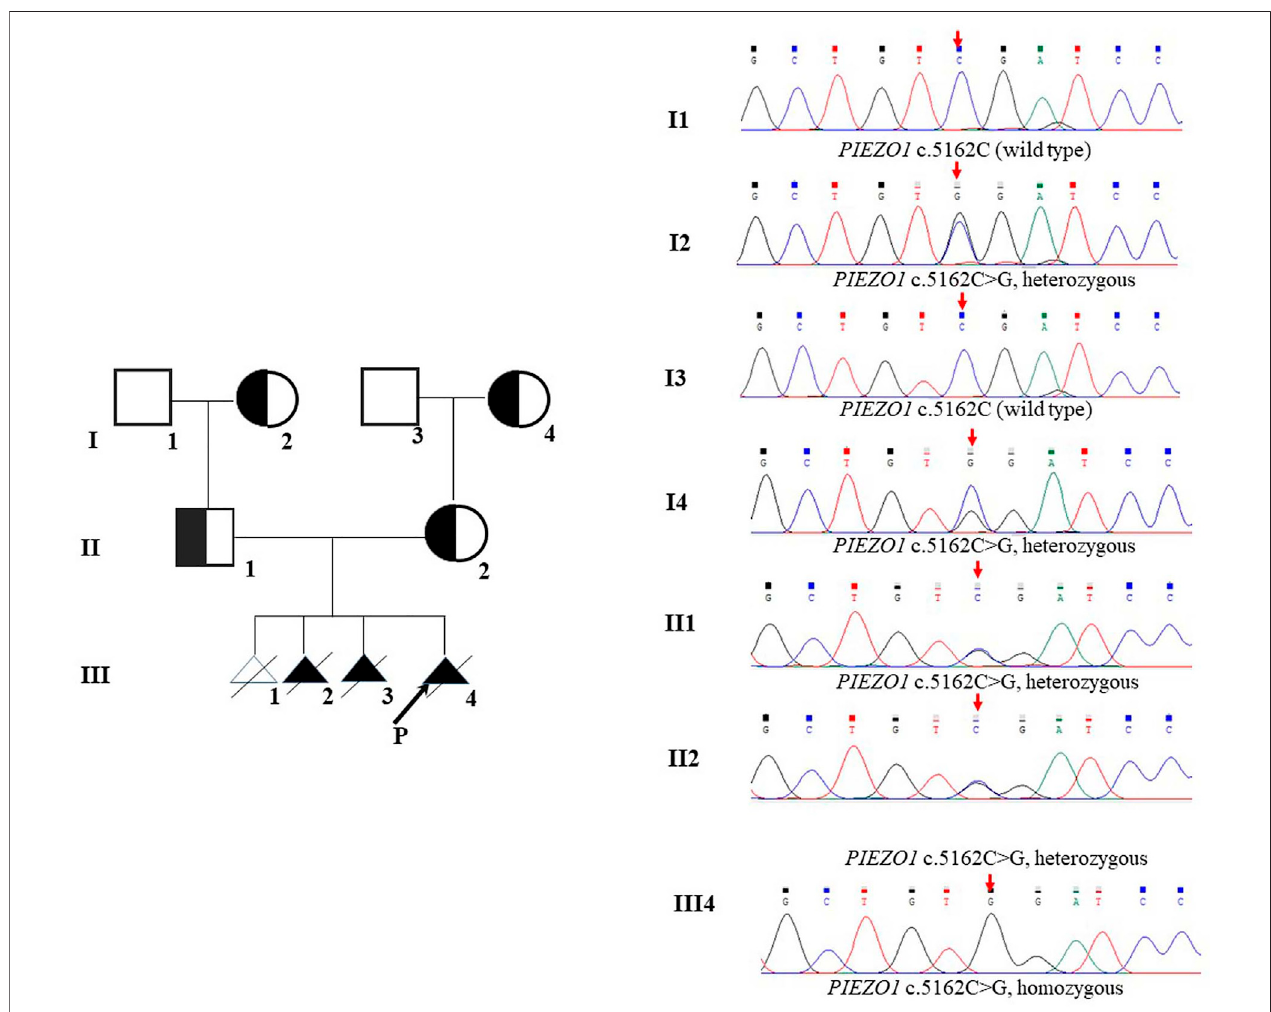
FIGURE 3 | Pedigrees and DNA sequences. The arrow in III shows the proband. The red arrows indicate the mutations.